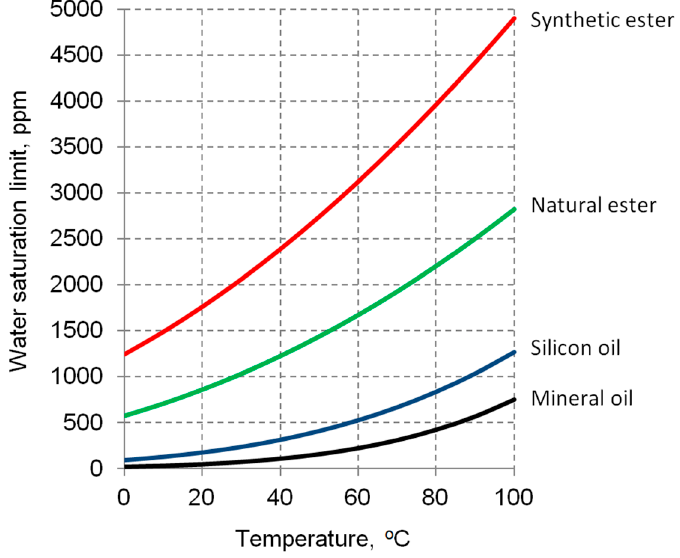
Figure 2. Comparison of water saturation limit for four different electro-insulating liquids; based on data from [44].